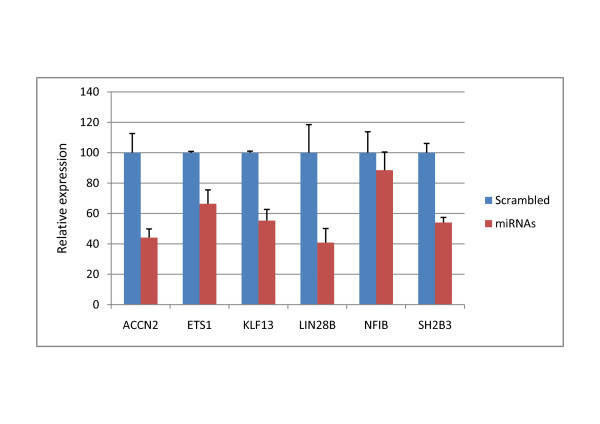
Overexpression of miRNAs reduces predicted target mRNA levels. Pools of miR-124, miR-125 and miR-9 miRNA mimics (miRNAs) or scrambled controls (Scrambled) were transfected into HEK293 cells. The mRNA expression of six genes predicted to be targeted by these three miRNAs was subsequently assessed by qRT-PCR. The graph shows the significant (P < 0.01) reduction in expression of ACCN2, ETS1, KLF13, LIN28B and SH2B3 following transfection with miRNAs relative to the scrambled control (error bars show standard deviation). There was no significant difference in expression of NFIB.